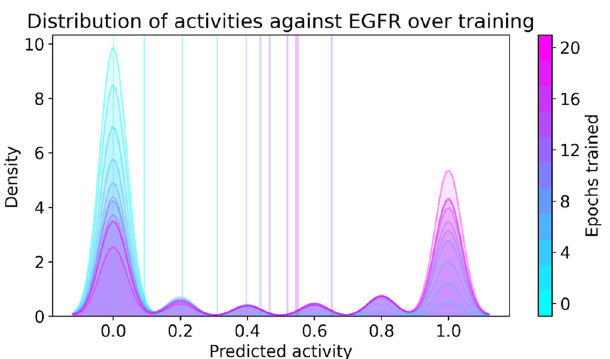
Fig. 5 Time-lapse distribution of active class probability values during training. Mean predictions are marked by vertical lines. The model was trained for 20 epochs with 15 steps of policy gradient, 10 steps of experience replay, and 20 steps of fi ne-tuning per epoch. 1000 batches of molecules were generated every 2 epochs, and the distribution of active class probability plotted. Note that the classi fi er with ensemble size fi ve generates discrete predictions of fi fth